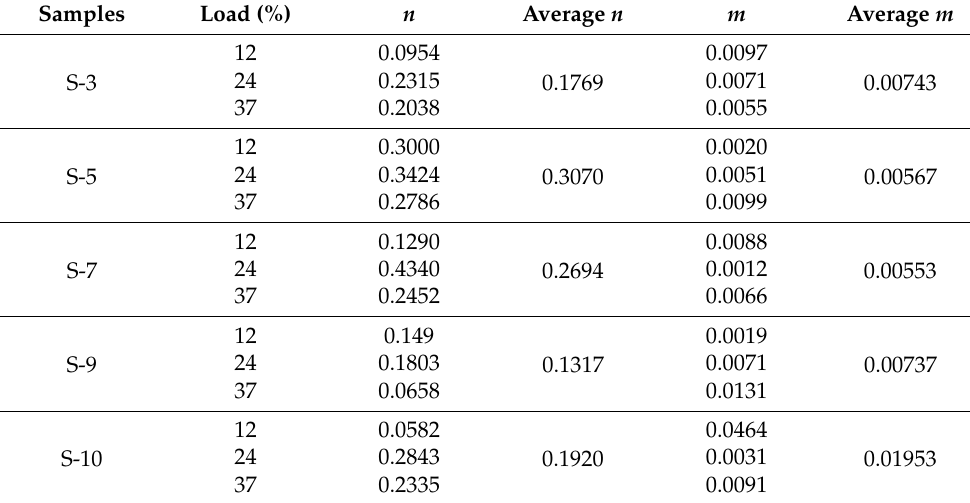
Table 5. m and n values for all composite configurations.